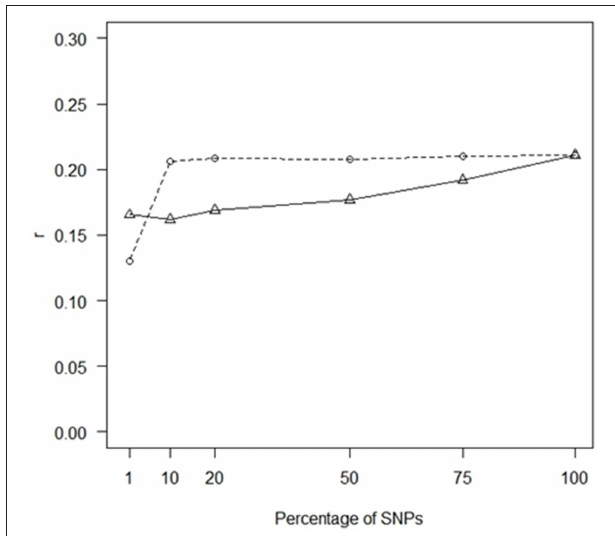
FIGURE 1 | Impact of SNP density on prediction accuracy. GBLUP correlations ( r ) for THS for different numbers of SNP markers; markers were chosen at random (dashed line) or based on p -values from GWAS performed in the training populations (straight line). The number of analyzed SNPs (crosses) were 1% (1063), 10% (10,629), 20% (21,257), 50% (53,141), 75% (79,712), and 100%